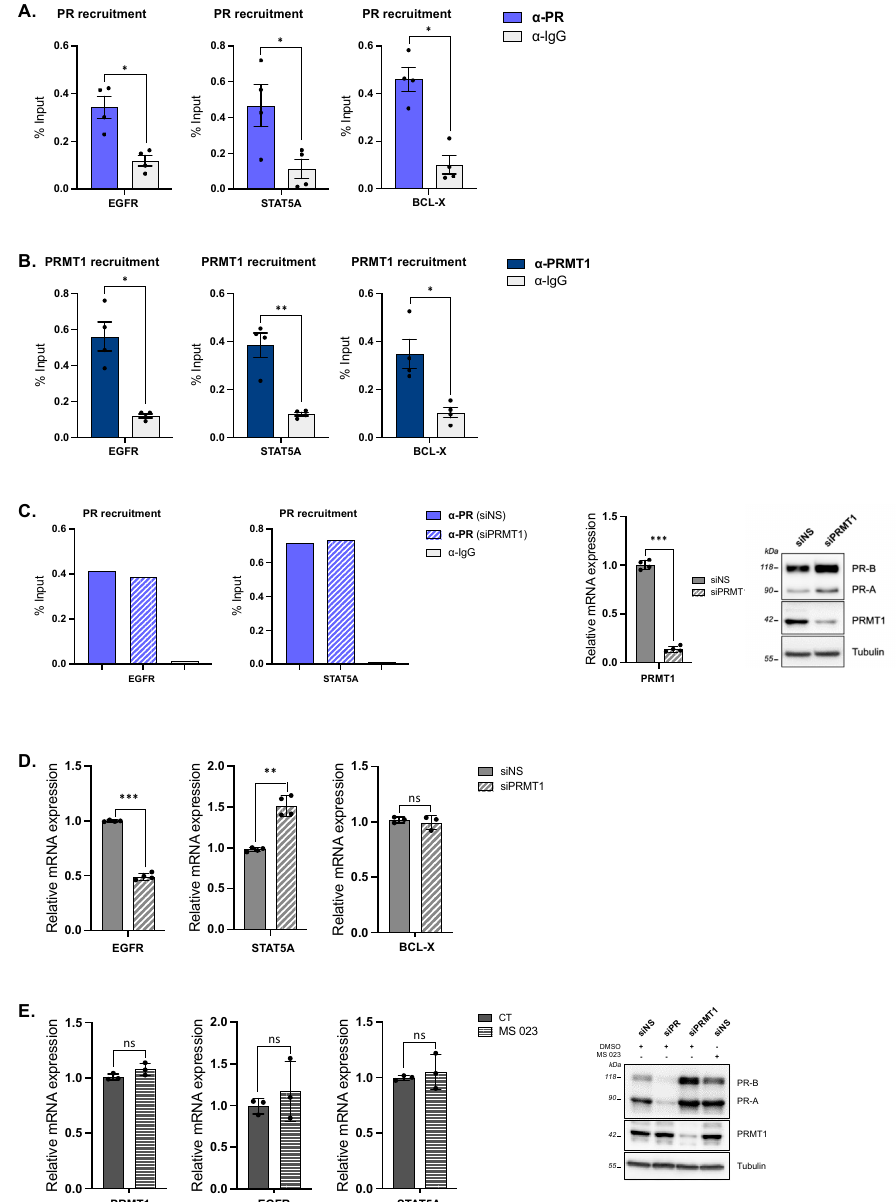
Figure 2. PRMT1 acts as a PR coregulator in the absence of hormones in T47D cells. ( A – B ) T47D cells were cultured in medium deprived of steroids for 48 h and then starved in serum-free medium for 24 h. Starved T47D cells were collected and subjected to chromatin immunoprecipitation (ChIP) with ( A ) anti-PR, ( B ) anti-PRMT1 antibodies, or control IgG. The precipitated DNA fragments were used for qPCR analysis using specific primers ( EGFR, STAT5A, or BCL-X ) with respect to the input DNA and normalized against a reference locus (human chromosome 1 gene). The p-value was cal- culated using a paired t -test: * indicates p ≤ 0.05 and ** p ≤ 0.01. The graphs show mean ± SEM of four independent experiments. ( C ) T47D cells, transfected with siNS or siPRMT1, were subjected to ChIP experiment with anti-PR antibody (or control IgG) and the recruitment of PR was analyzed using qPCR on two different target genes ( EGFR, STAT5A ), with respect to input DNA and normal- ized against a reference locus (human chromosome 1 gene). Left panel: The graphs show one ex- periment representative of two. Right panel: The efficacy of PRMT1 siRNA treatment was analyzed by qPCR (graph) and IB. Tubulin was used as a loading control. ( D , E ) Total RNA from T47D cells ( D ) transfected with non-silencing control siRNA (siNS) or with anti-PRMT1 (siPRMT1) siRNAs or